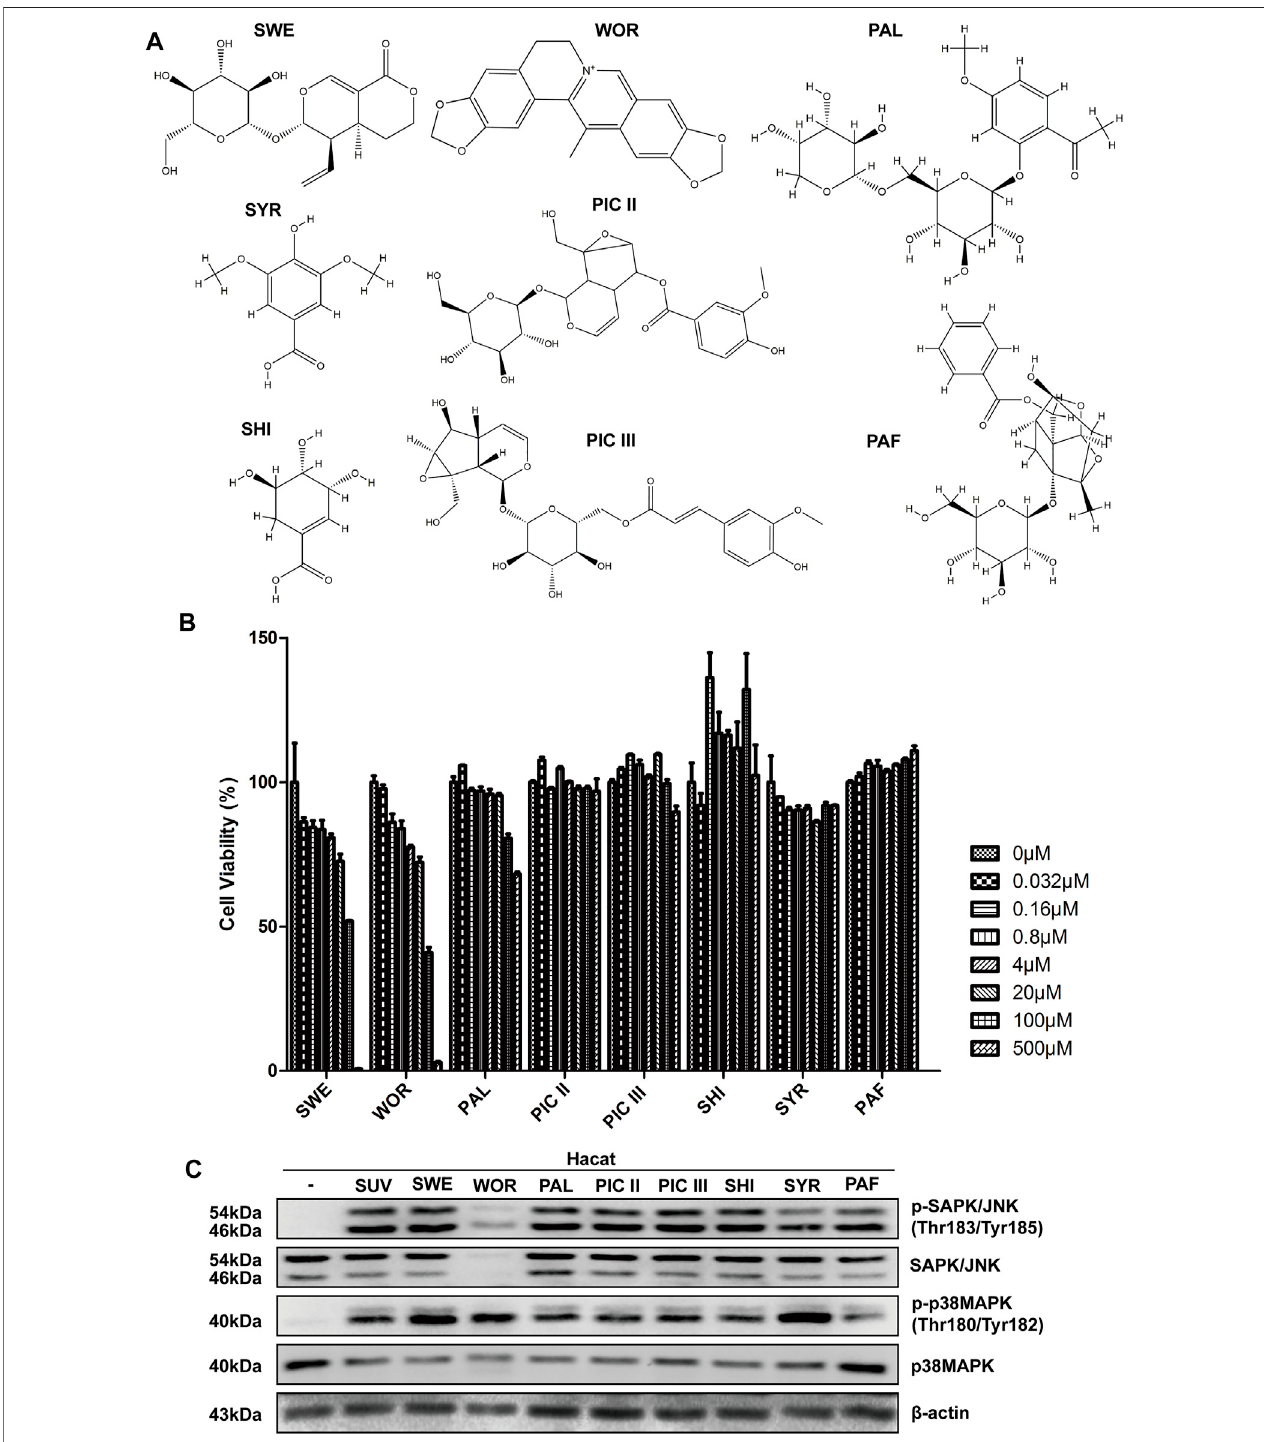
FIGURE1| Worenineinhibitstheincreaseofp-JNKinducedbySUV. (A) ThechemicalstructuralformulasofeightkindsoftraditionalChinesemedicinebiologically active compounds. (B) HaCaT cells treated with these compounds for 48 h, and cell viabilitymeasured by MTT. (C) HaCaT cells treated with these compounds for 12 h followed by SUV irradiation. Cells were collected to detect the phosphorylation levels of JNK and p38 by Western blot using the corresponding antibodies.